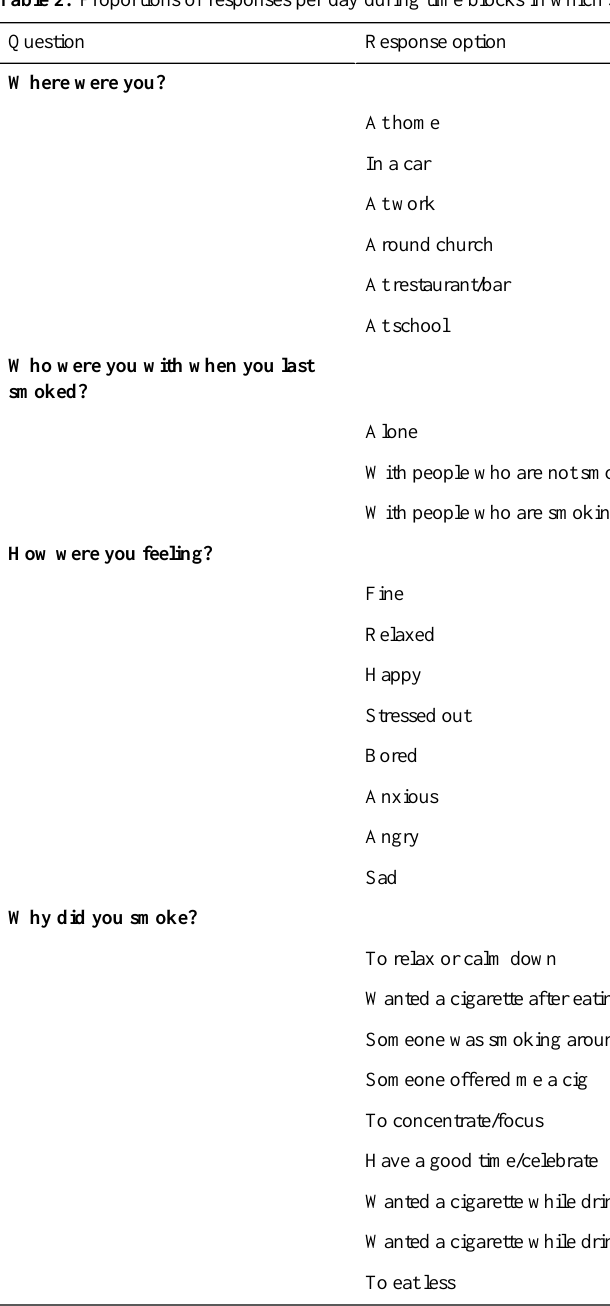
Table 2. Proportions of responses per day during time blocks in which smoking was reported. Where were